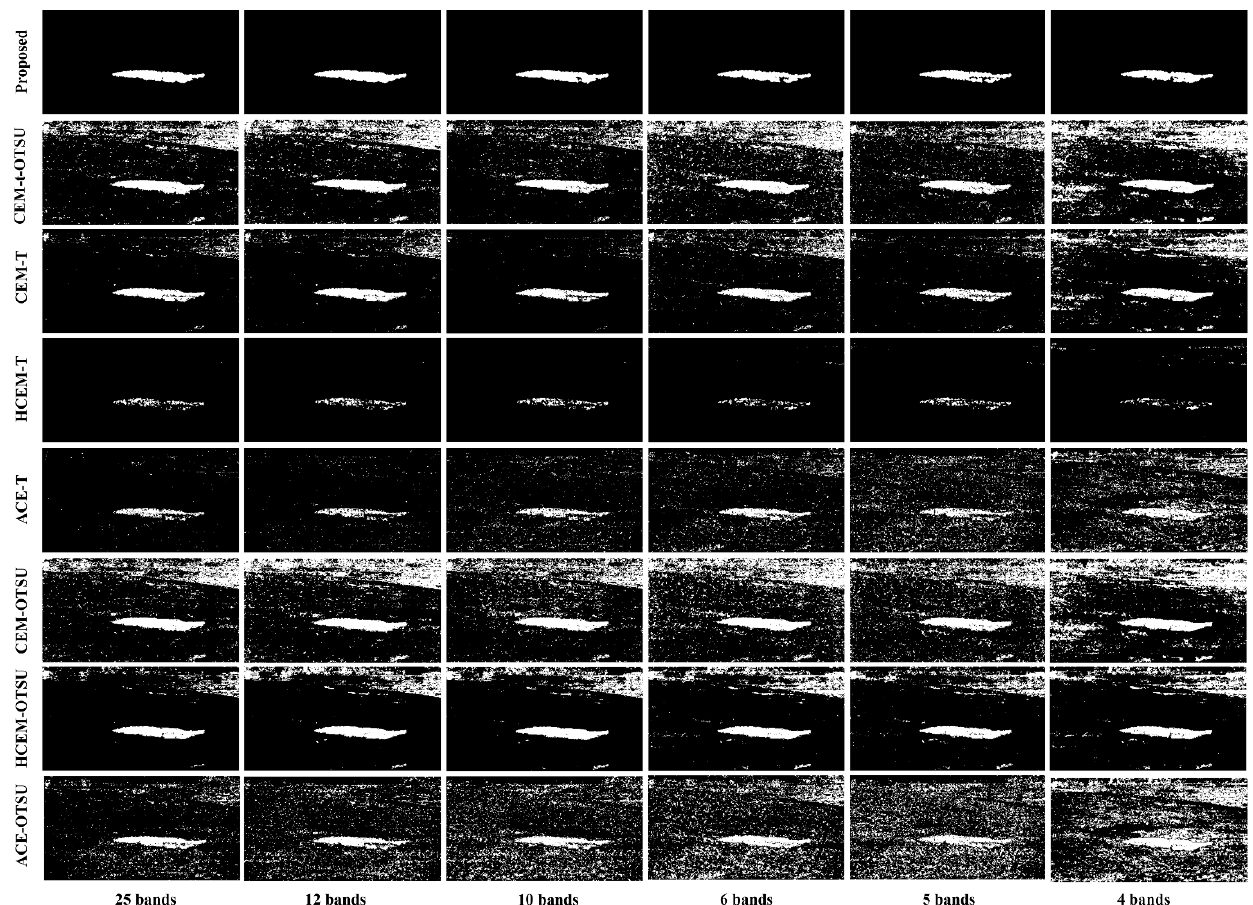
Figure 7. The detection results of different methods for the AIRC-net in the Lawn scene with bands ranging from 4 to 25. All the results are normalized to [0,1] for a fair comparison.